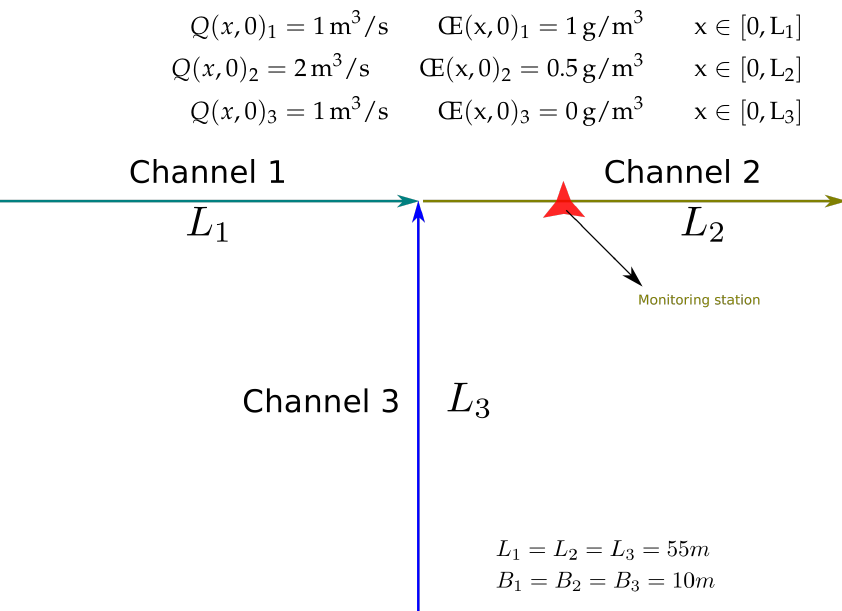
Figure 4. Case 1. Schematic of the three channels at a 90°